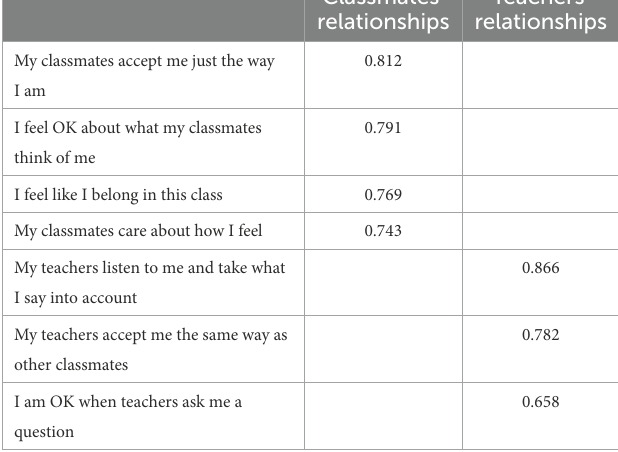
Classmates’ Teachers’ relationships